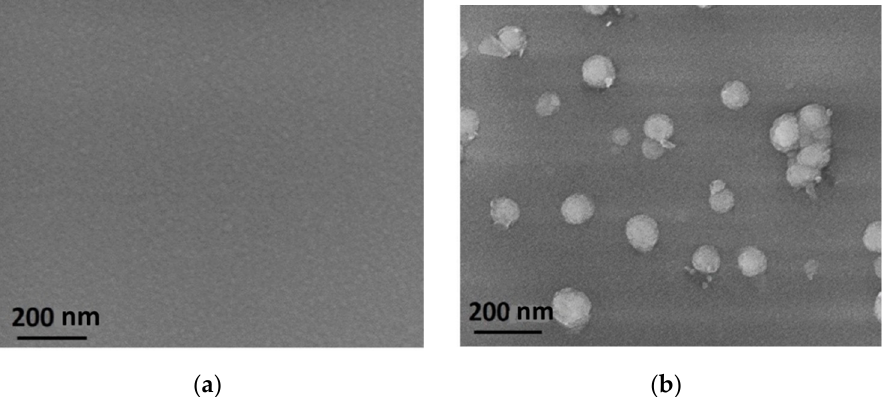
Figure 8. SEM images of a-SiN x sputtered at a H 2 flow rate of 12 sccm: ( a ) surface before annealing, ( b ) surface after annealing at 800 °C.